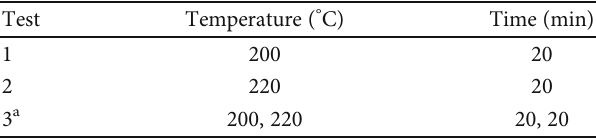
Table 3: Conditions for the thermal stabilization of fi